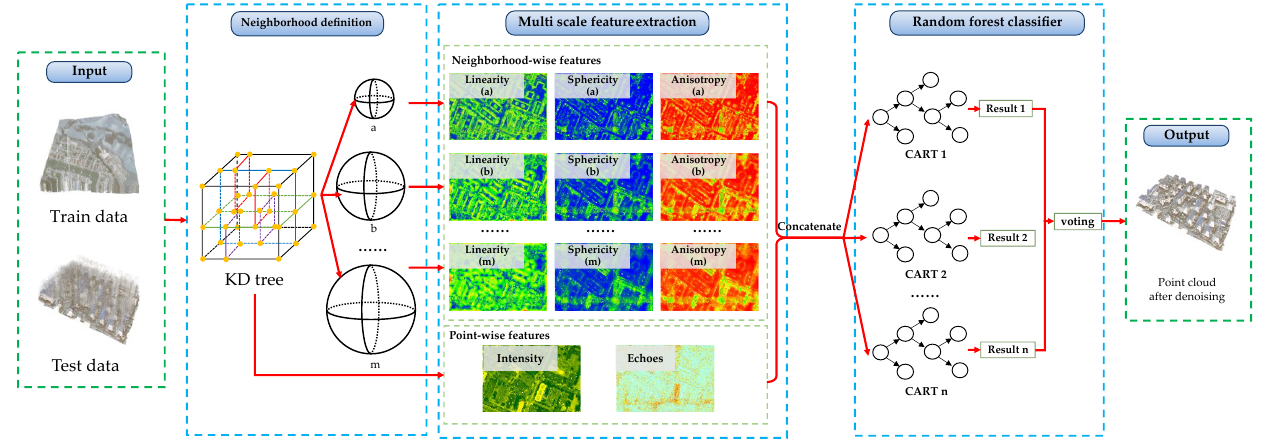
Figure 2. Structure of the proposed network. There are three main parts: neighborhood definition, a multiscale feature extraction, and a random forests module. In the neighborhood definition module, a,b...m represent different